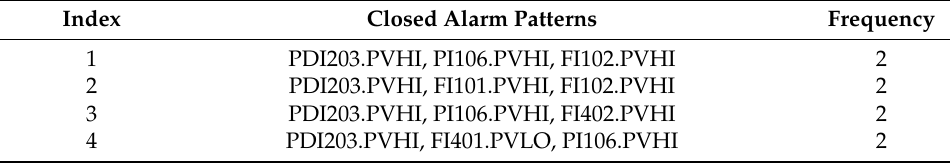
Table 9. Alarm patterns extracted by C_PrefixSpan.